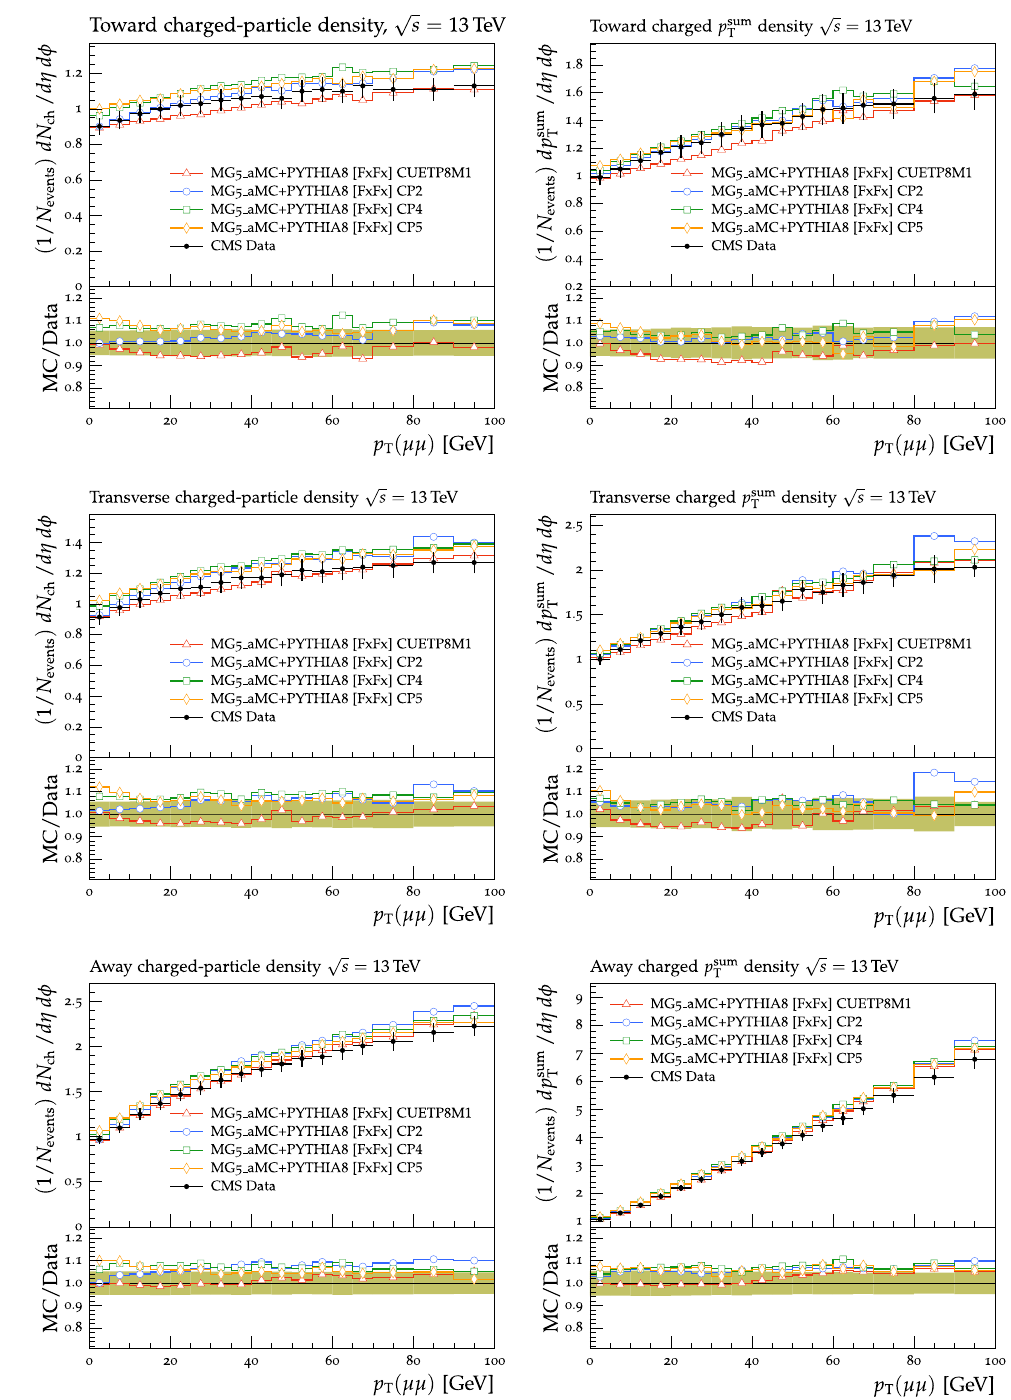
Fig. 21 The charged-particle multiplicity (left) and p sum toward(upper),transverse(middle),andaway(lower)regionsmeasured as a function of the Z boson p T in Drell–Yan events at [21], and compared with the predictions obtained by an inclusive NLO MEcalculatedby mg5 _a mc ,interfacedtotheUEsimulationof pythia 8 with the CUETP8M1, CP2, CP4, and CP5 tunes. Tunes CP1 and CP3 arenotshownintheplotbutpresentasimilarbehaviouras,respectively,